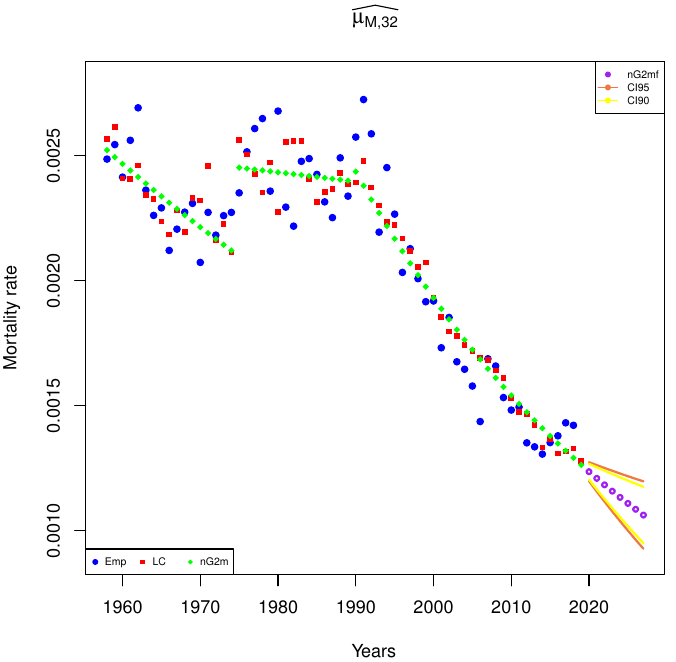
Figure 3. The values of mortality rates—male, age 32: empirical (Emp), theoretical (LC, nGMs), forecasts (nGMsf), and c. interval based on the LC, and nGM model with Markov switch. µ M,36